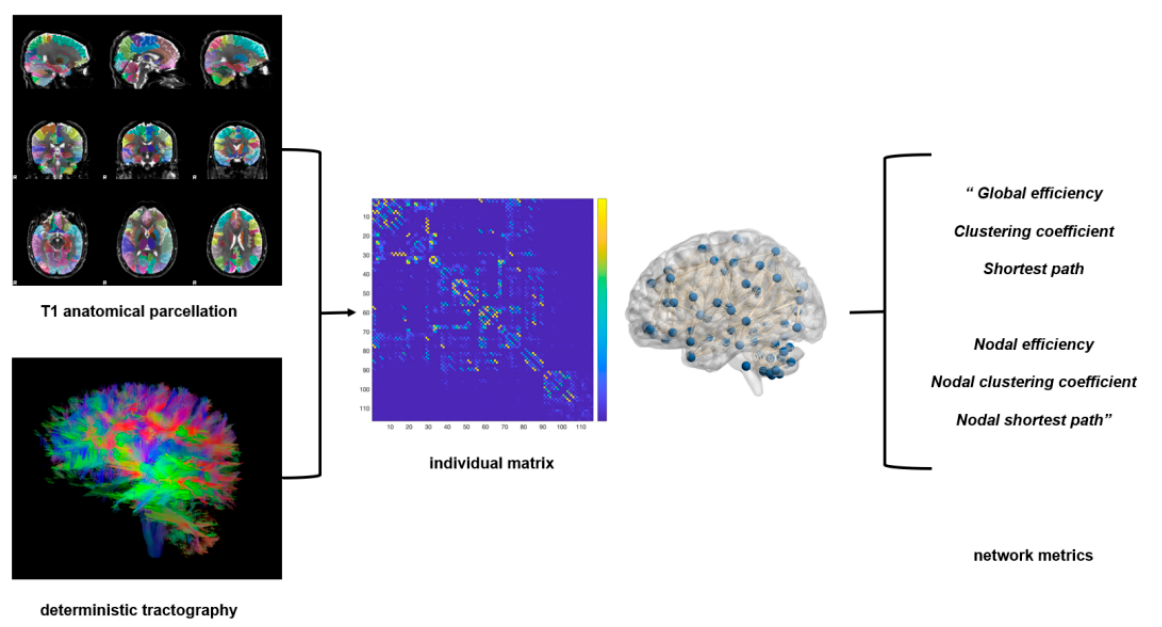
Figure 1. Flow chart of structural network construction. Deterministic tractography was performed for connectome reconstruction, while the cerebral cortex was parcellated into 116 brain regions according to the automated anatomical labeling (AAL) atlas and then aligned to native DTI space to constrain the fiber tracing. The nodes of the structural networks were defined as the 116 brain regions according to the AAL atlas. Edge weights were defined as the streamline counts connecting each pair of nodes end-to-end. Then, both the global and nodal network metrics were calculated. The global metrics included global efficiency, shortest path, and clustering coefficient; the nodal metrics included nodal efficiency, nodal shortest path, and nodal clustering coefficient.